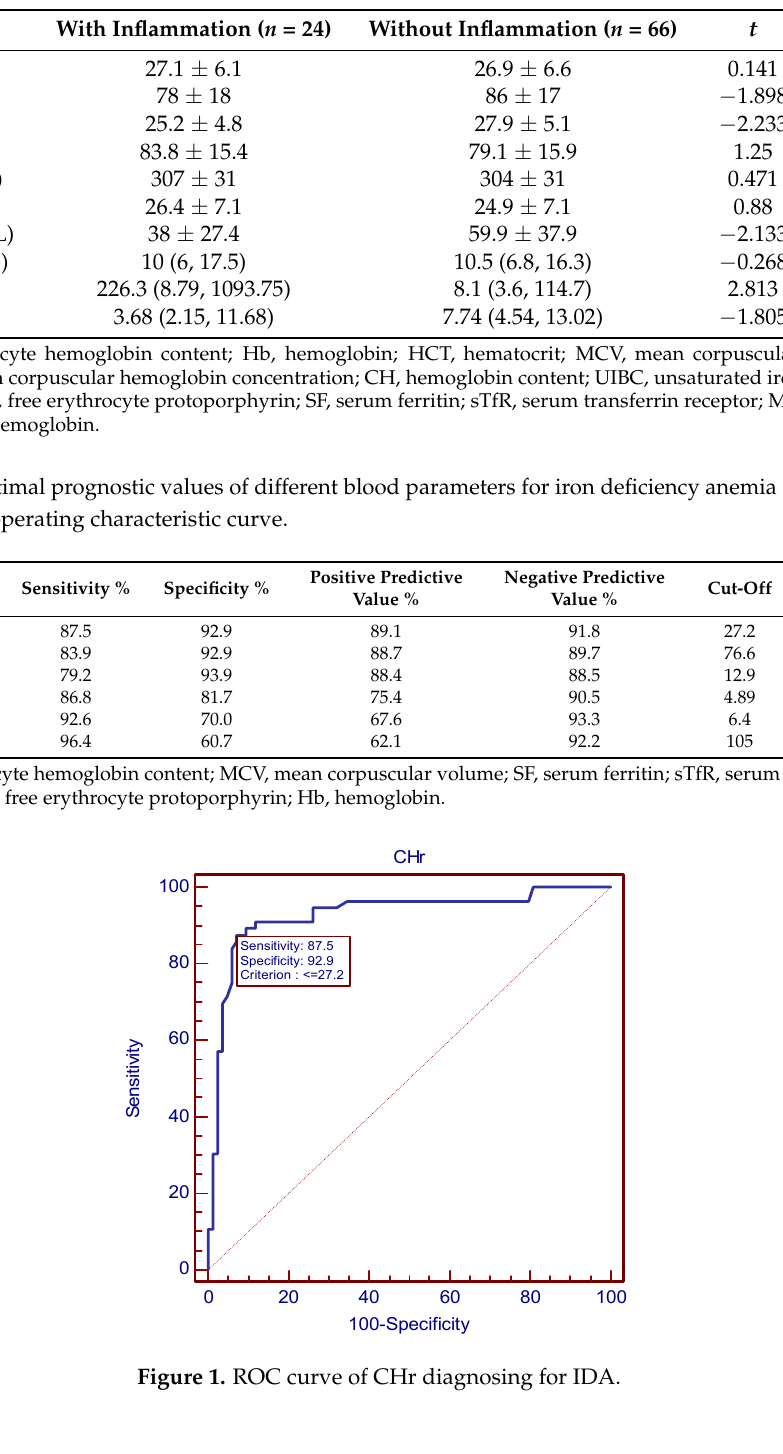
Table 3. Comparison of hematologic and biochemical indexes results for subjects with and without inflammation in IDA group and NIDA group.